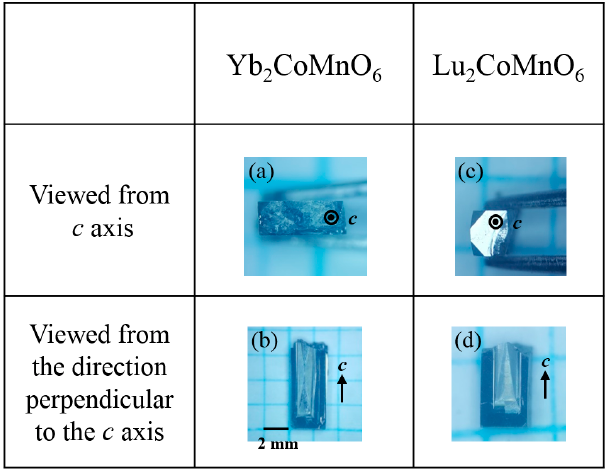
Figure 1. Images of representative single crystals of Yb 2 CoMnO 6 (YCMO) ( a , b ) and Lu 2 CoMnO 6 (LCMO) ( c , d ) viewed from the c axis and from the direction perpendicular to the c axis. The length of each side for the squares of grid pattern is 2 mm.